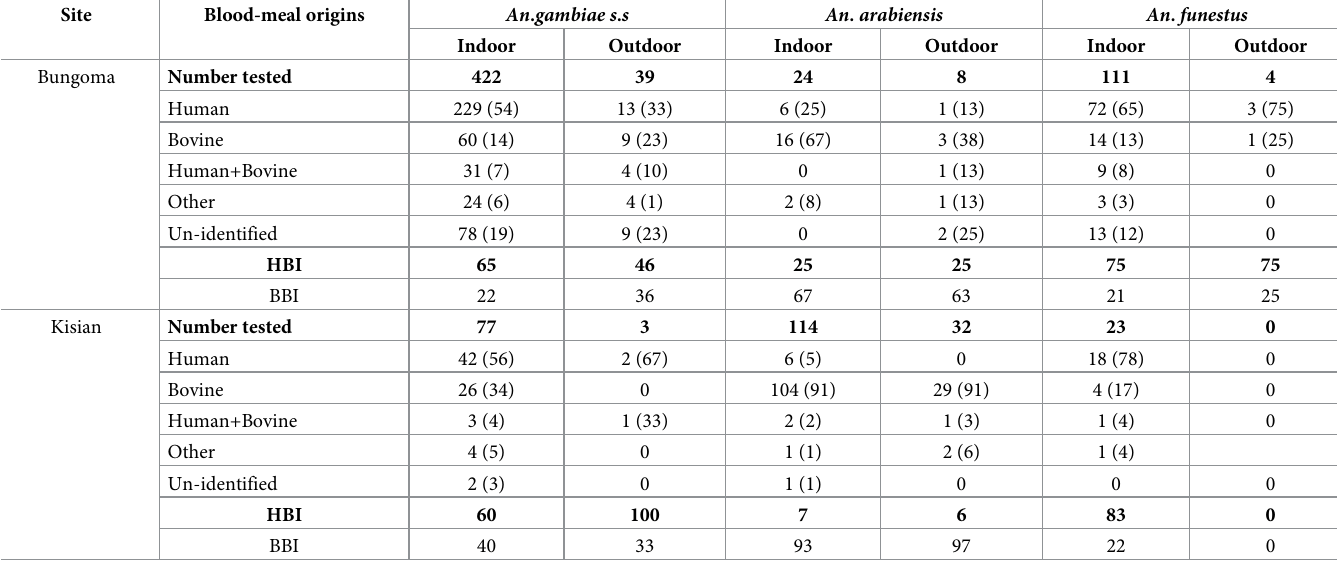
Table 2. Blood meal origins of Anopheline mosquitoes collected from indoor and outdoor in Bungoma and Kisian, western Kenya.